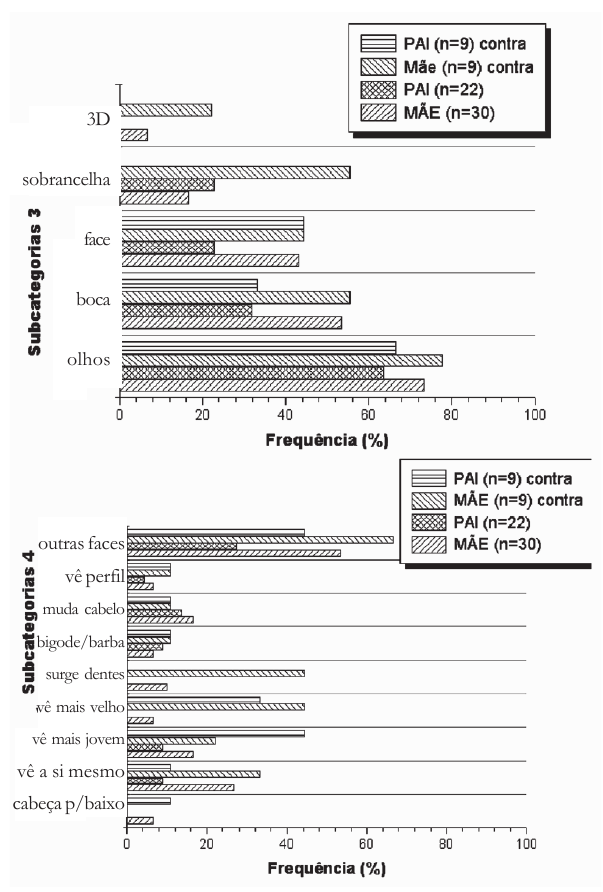
Figura 5. Porcentagens de ocorrência do fenômeno de muitas-faces nas subcategorias 3 e 4. As condições no ponto cego e contralateral são comparadas para mãe e